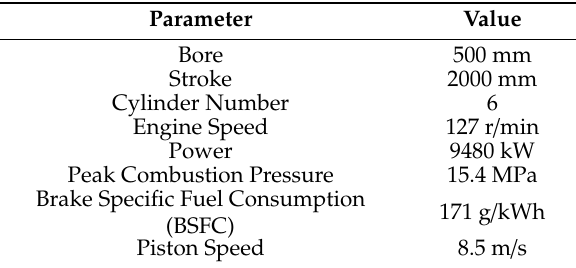
Table 1. MAN 6S50ME engine dimensions.